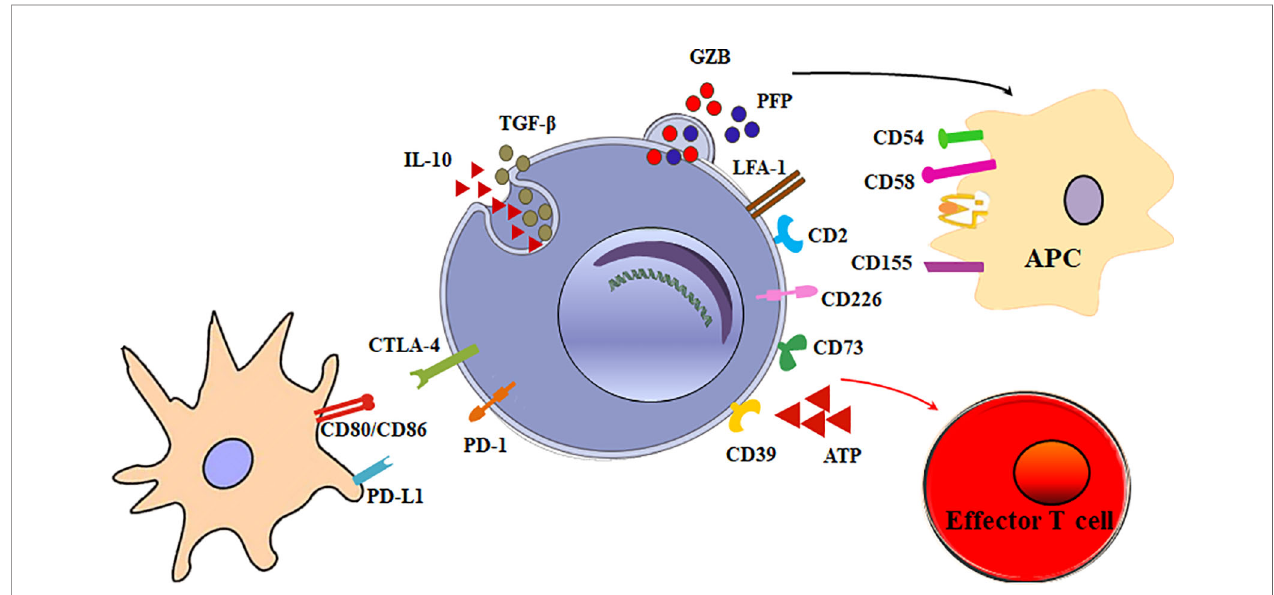
FIGURE 2 | Multiple suppressive mechanisms of Tr1 cells in immune responses. The mechanisms of Tr1 cells to inhibit effector cells include: (1) Tr1 cells exert their suppressive function primarily via the secretion of IL-10 and TGF- b . (2) Tr1 cells contact and suppress other effector cells through inhibitory receptors, including CTLA-4 and PD-1. (3) Tr1 cells selectively kill myeloid APCs via secretion of Granzyme B and perforin to inhibit effector T cells. (4) CD39 and CD73 on Tr1 cells produce adenosine which increase intracellular cAMP levels and disrupts effector T cell